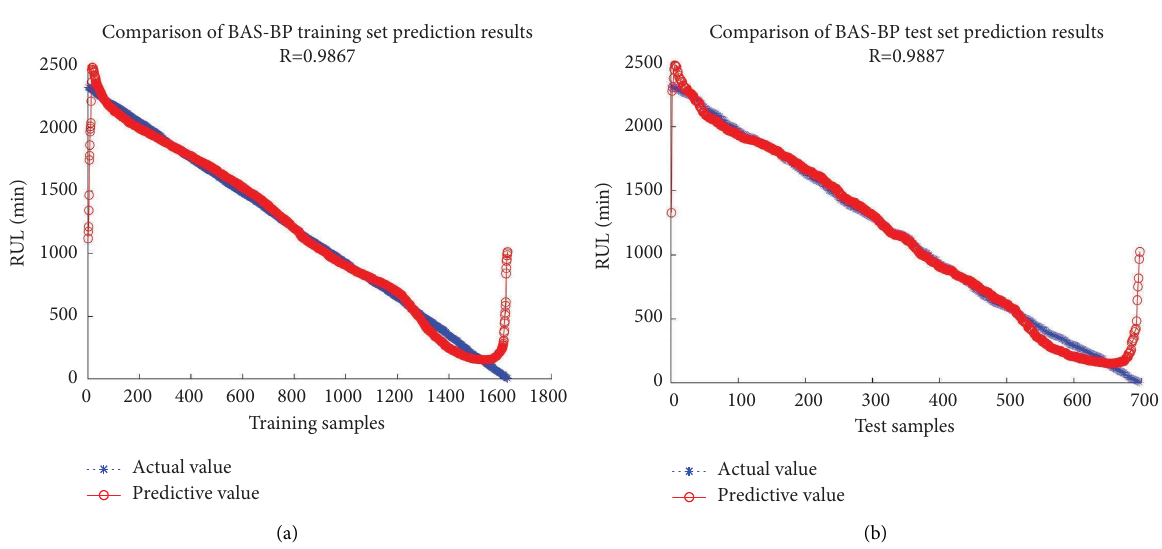
Figure 15: BAS-BP model prediction results of no. 2. (a) Training set. (b) Test